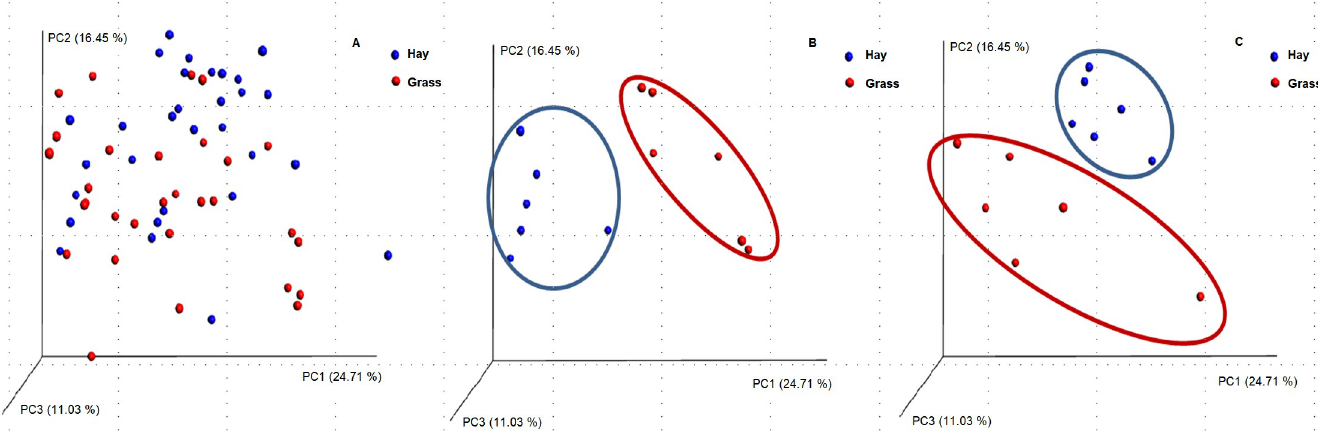
Fig 3. PCA on a weighted-UniFrac dissimilarity matrix for data on the microbial membership and structure in the faeces of ponies. (A) Days 1, 2, 3, 7, 14 on grass and hay (H-D1, H-D2, H-D3, H-D7, H-D14, G-D1, G-D2, G-D3, G-D7, G-D14) (B) Day 1 after abrupt change on grass and hay (H-D1, G-D1) (C) Day 3 after abrupt change on grass and hay (H-D3, G-D3). OTUs with < 100 reads were excluded from the analysis. n = 6. H: hay; G: grass; D: day; PCA: Principal coordinate analysis.